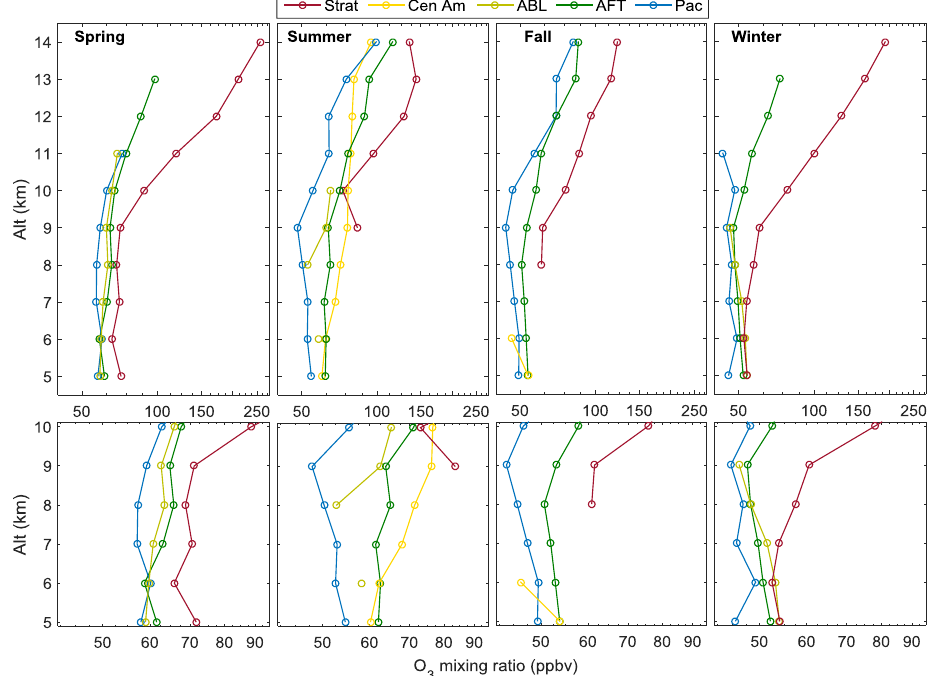
Figure 11. (a) Composite profiles of the ozone mixing ratio associated with the different categories and for each season. Results are shown only when the number of samples for a given category was larger than 5% of the total number of samples in that season. (b) Same as panel (a) but zoomed in the region from 5 to